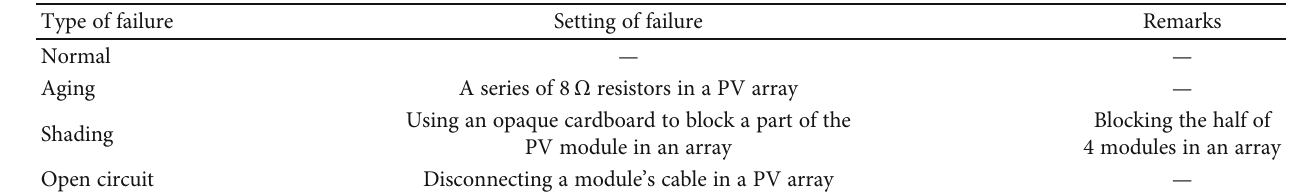
Table 2: Settings of di ff erent